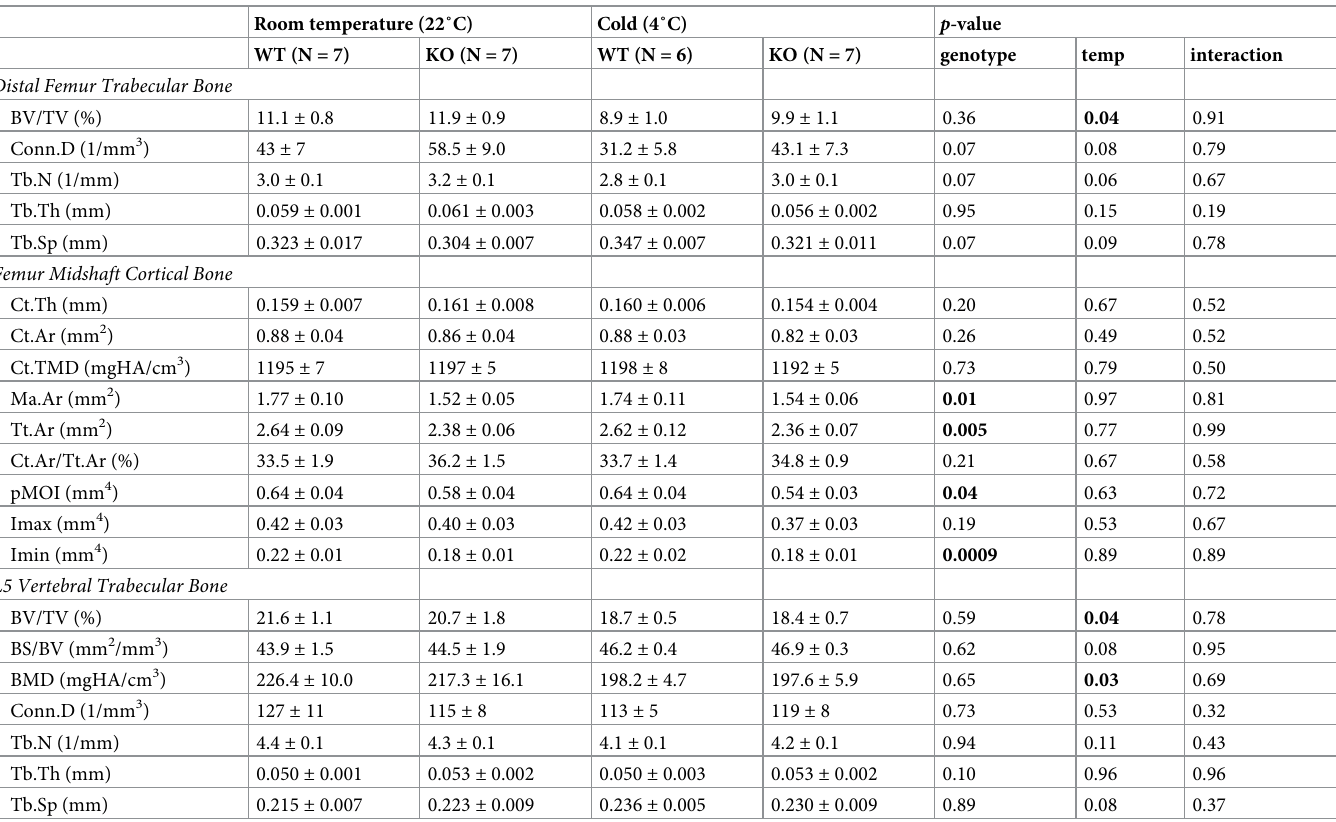
Table 1. Femoral and vertebral bone outcomes assessed by μ CT of male wildtype (WT) and Trpm8 - Knockout ( KO ) mice housed at room temperature or cold. Room temperature